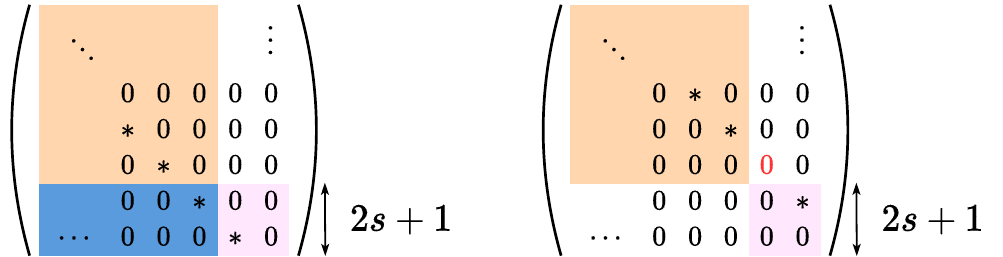
(left) and S + (right) in the infinite-dimensional s s ⊕ V (cid:90) ∗ represent non-zero for s ∈ 1 ≥ 0 . The a (cid:48)(cid:48) 2 a (cid:48) (resp. V ), while the rectangular a (cid:48)(cid:48) a (cid:48) to V . Note that we order the basis decreasingly, ··· , | 1 〉 , | 0 〉 , a (cid:48)(cid:48) a (cid:48)